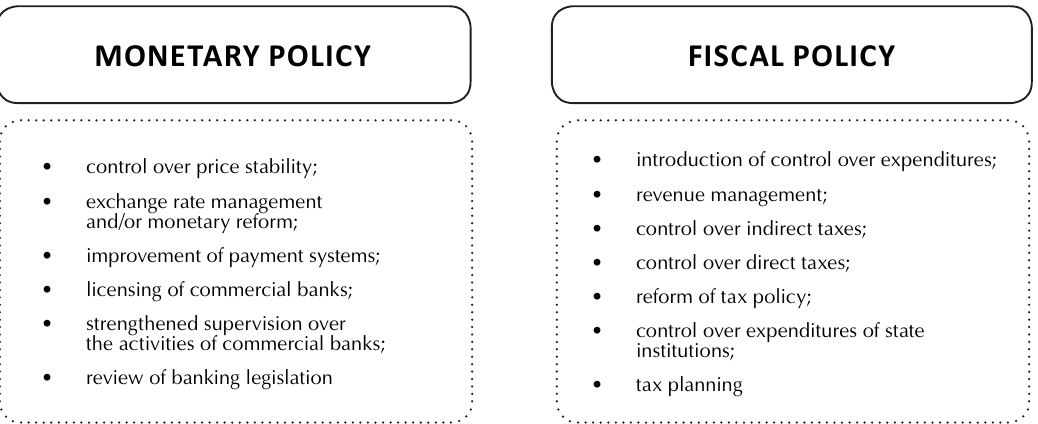
Figure 1. Key measures of fiscal and monetary policy in post-conflict recovery